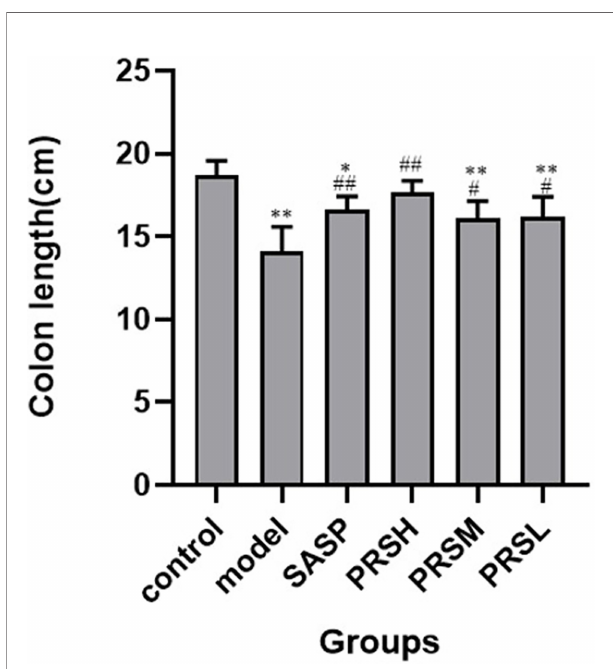
FIGURE 3 | Lengths of colons from each group of rat. Data are presented as means ± SD (n = 6 per group). # p < 0.05 and ## p < 0.01 vs the model group on the same day; *p < 0.05 and **p < 0.01 vs the control group.